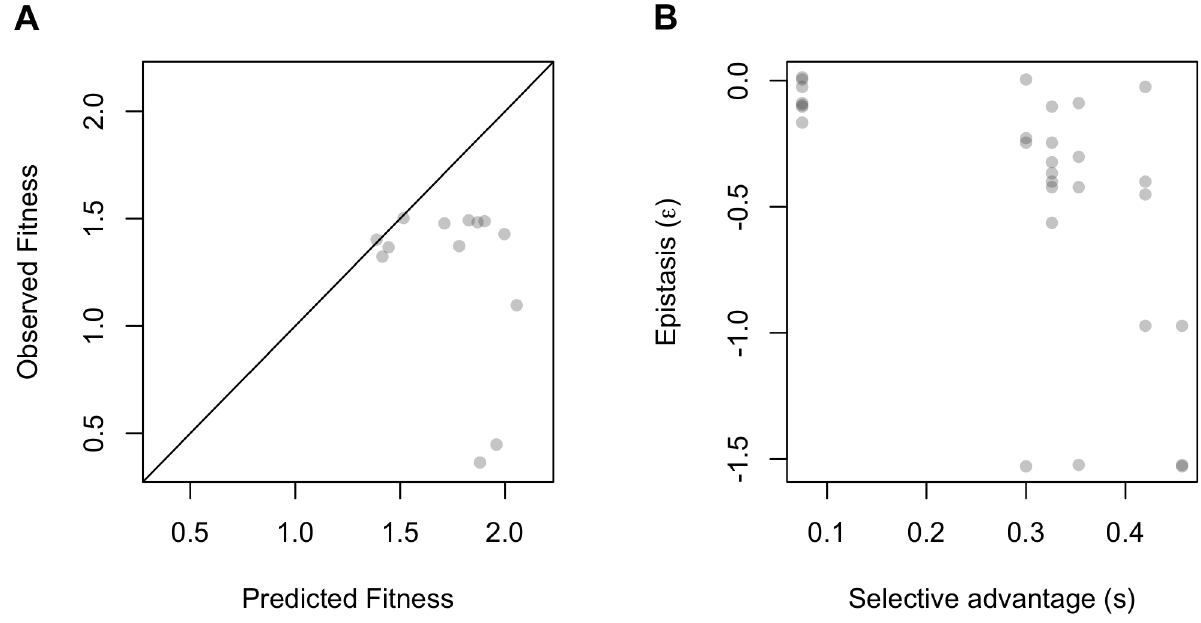
Figure 2. Epistasis at the level of expression phenotypes and fitness relative to independence or kinetic model. A) Fitness values of mutation combinations are consistently lower than expected by multiplicative independence. B) Mutations with larger with selective advantages ( s ) when tested alone in the ancestor have more negative e values in combination with other mutations.